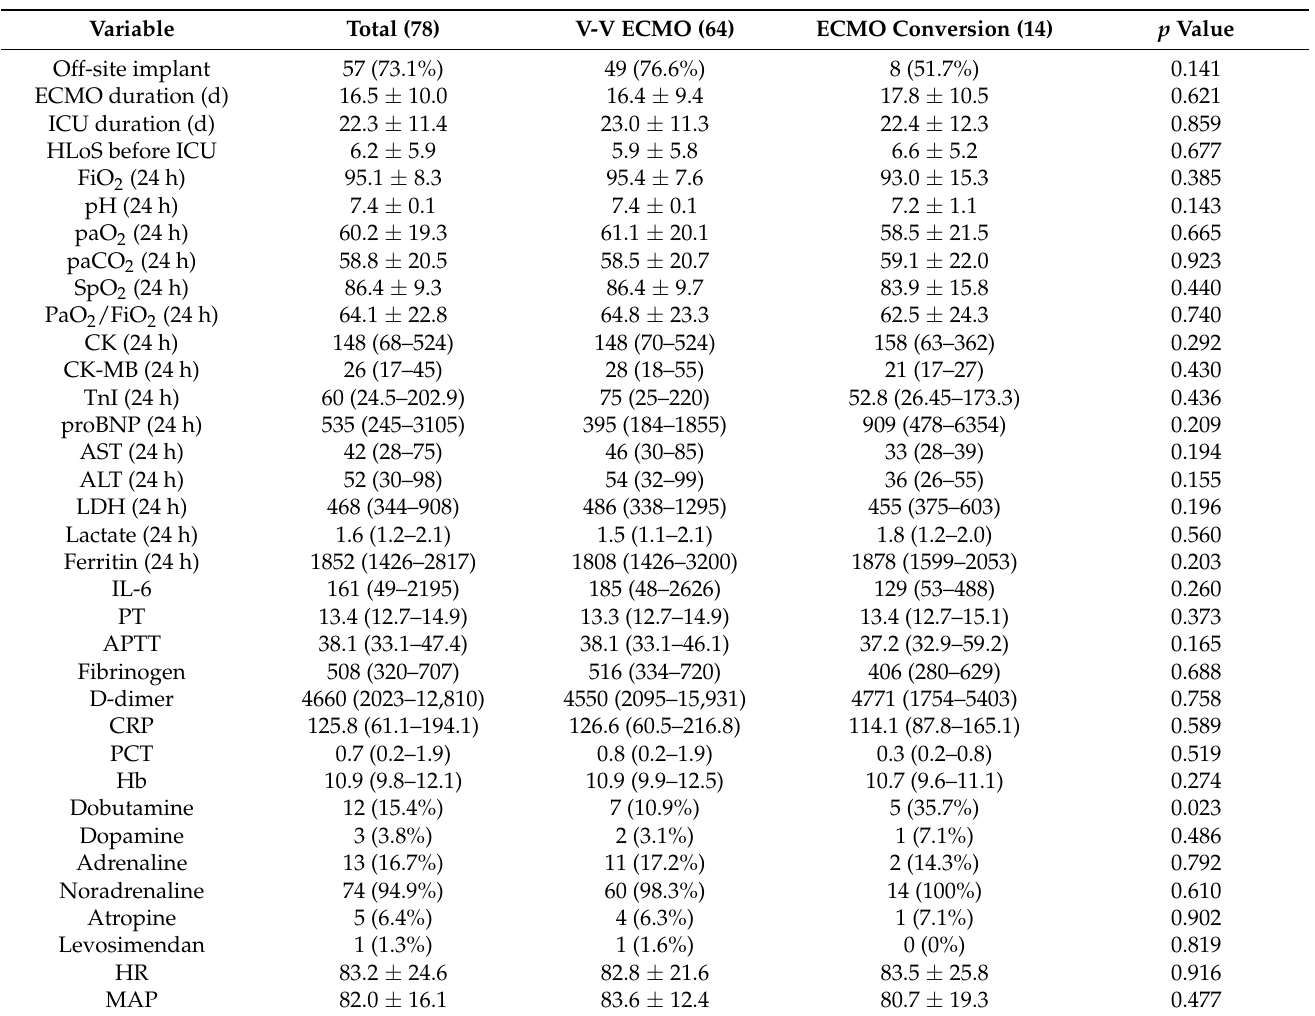
Table 2. On-ECMO